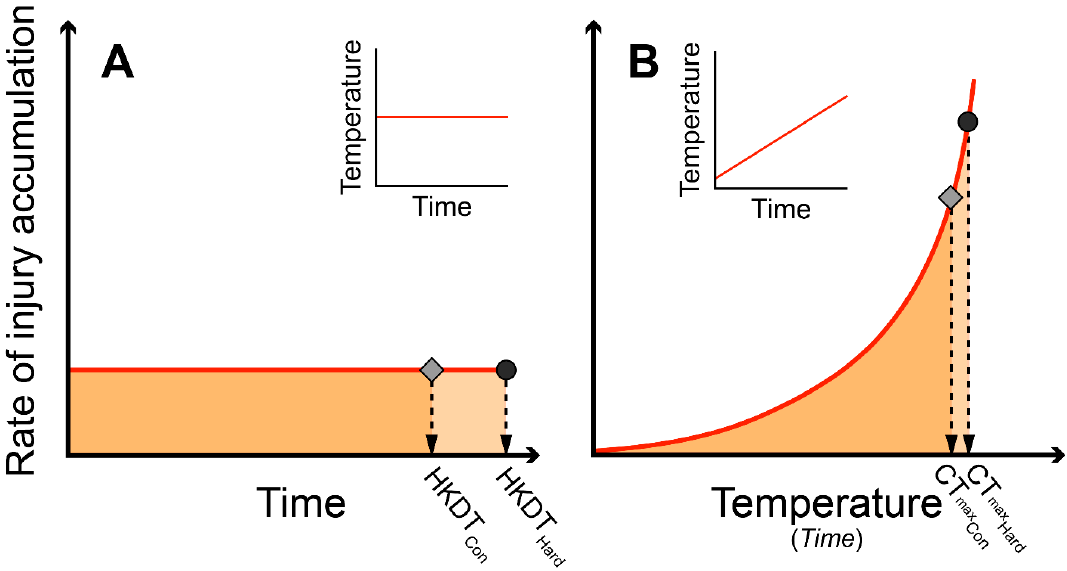
Figure 1. Theoretical development of heat injury in static and dynamic heat tolerance assays. ( A ) In a static assay, the animal is exposed acutely to a constant stressful temperature (see insert in ( A )) and, hence, injury will accumulate at a constant rate until knockdown. The time of physiological failure in control animals is recorded as the heat knockdown time (HKDT con ) and the accumulated injury during the assay is here depicted as the area below the curve. Heat hardening can change heat tolerance which can result in a higher HKDT (HKDT Hard ). ( B ) In a dynamic heat tolerance assay the temperature is increased at a fixed rate (see insert in ( B )). The rate of injury accumulation increases exponentially with temperature in a dynamic assay and heat tolerance is typically measured as the temperature of heat coma (CT max ). Here, we use CT max Con and CT max Hard for control and hardened animals, respectively. If the two assays (static and dynamic) measure the same physiological response to heat stress, then it is possible to predict CT max in a dynamic test from the HKDT in the static test. This analysis requires knowledge of the exponent that describes how the rate of injury accumulation increases exponentially with temperature, the rate of temperature change (ramp rate), and an assumption of the temperature above which injury starts to